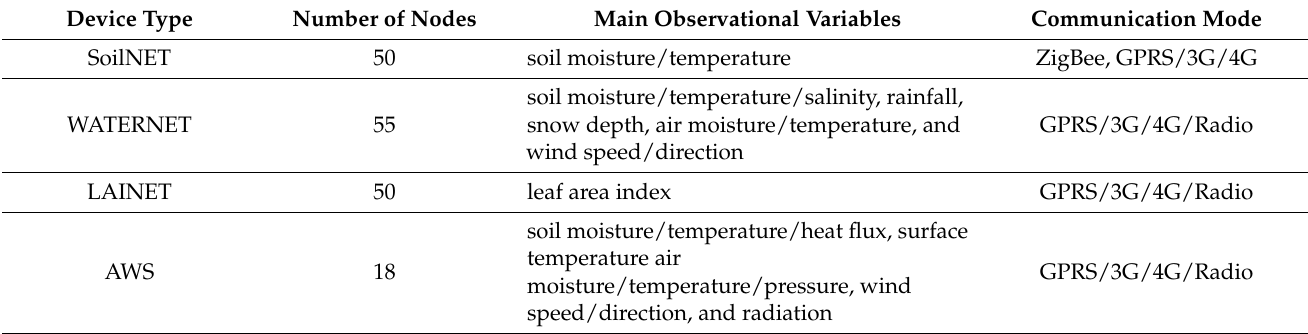
Figure 8. Layout of the WSN observational nodes in the middle reaches of the HRB [43]. Table 3. Observational devices installed in the core observational area, their related observational variables, and their wireless communication